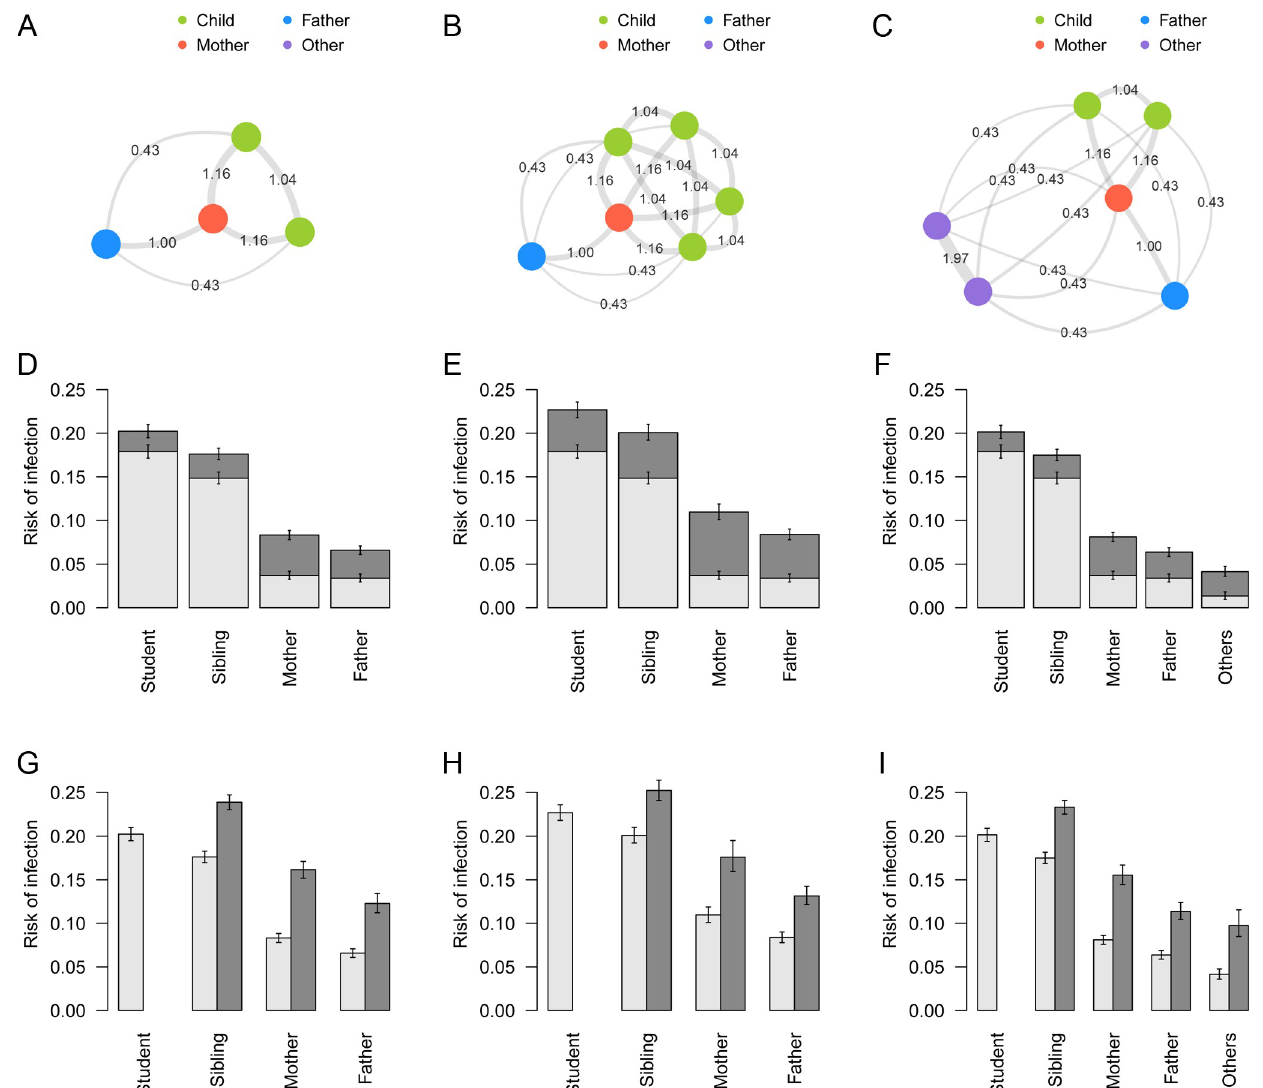
Fig 3. Contact patterns and risk of infection in specific household compositions. (A)-(C) Network graphs showing contact intensity between individuals for different household compositions: (A) “nuclear family”, (B) “many-siblings family”, (C) “three-generation family”. Node colours represent the type of individuals. Edges denote the relative intensity of contact ( c kl ) between individuals. (D)-(F) Risk of infection in households of different compositions stratified by source. Light grey: risk of infection from outside the household; dark grey: risk of infection from within the household. Whiskers indicate the 95% CrI. (G)-(I) Unconditional risk of infection and conditional risk given an introduction of infection into a household. Light grey: overall risk of infection for each individual in the household; dark grey: risk of overall infection conditional that a student is infected outside and introduces infection into the household. Infection of the student is considered given, and thus the conditional risk for the student is not shown. Whiskers indicate the 95% CrI.